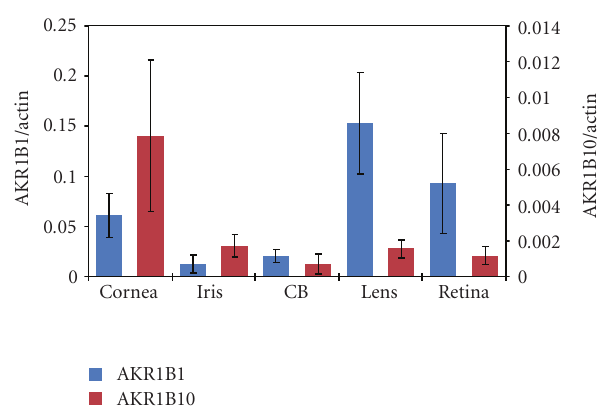
Figure 1: Expression of AKR1B1 and AKR1B10 in human eye tissues. Gene transcript levels were measured by quantitative real- time PCR as described in Section 2. Data are mean ± SD among 5 nondiabetic male donors aged 65. ± 9.2 years. Data for AKR gene transcripts levels are normalized to RT-PCR for β